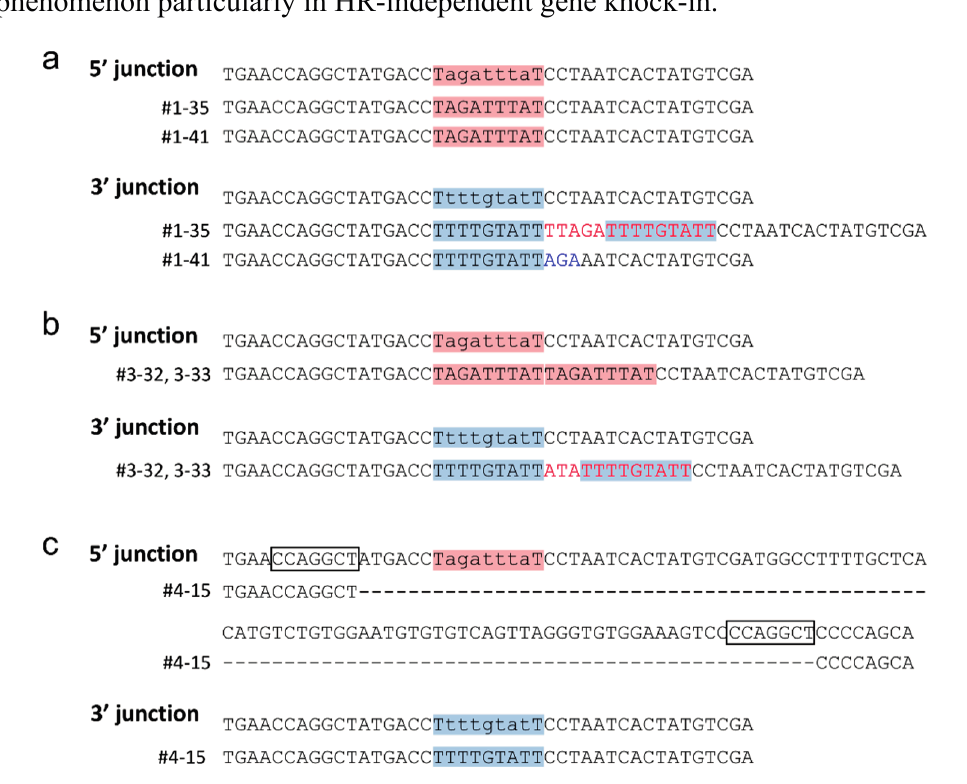
Figure 5. Sequences of 5 ′ and 3 ′ junctions of knock-in cell clones. The results were shown separately for whole plasmid knock-in without carrying an scFv-Fc cassette ( a ), whole plasmid knock-in carrying an scFv-Fc cassette with puromycin selection from 24 h post-transfection ( b ), and backbone-free knock-in ( c ). Intended knock-in junctions are shown at the top of each panel. Pink and blue boxes indicate designed microhomologies. Black boxes indicate accidentally existed microhomologies. Red letters indicate